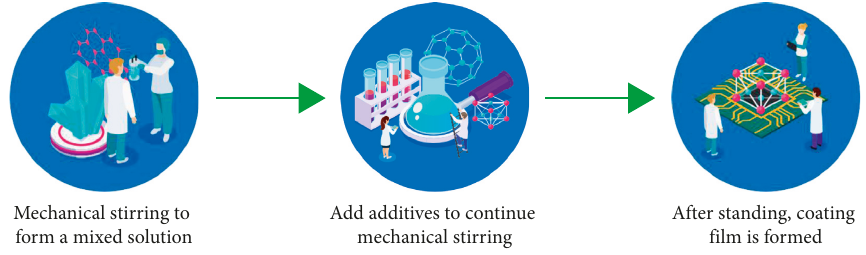
Figure 1: Process parameters of nanometer heavy-duty coating in power generation Table 1: Salinity of seawater in four major sea areas.